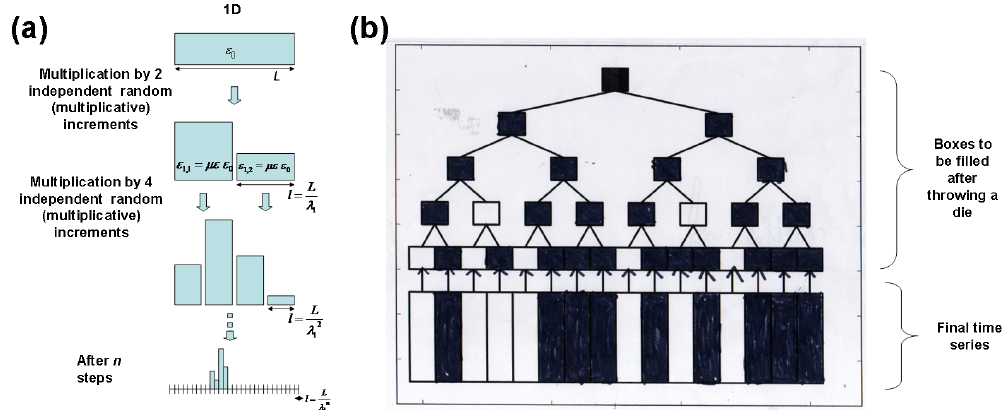
Figure 5. (a) Illustration of the pedagogical case of discrete multiplicative cascades. (b) Illustration of activity designed to mimic the specific case of the β -model